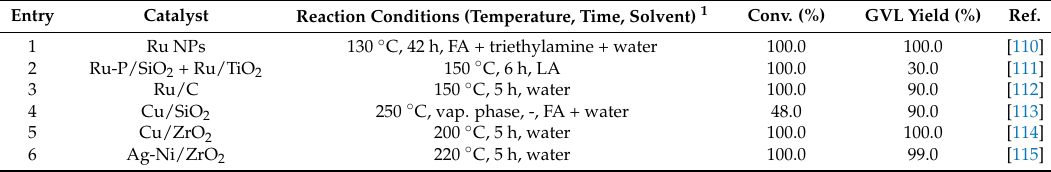
Table 6. Catalytic systems for the production GVL from LA and derivatives using FA as a hydrogen